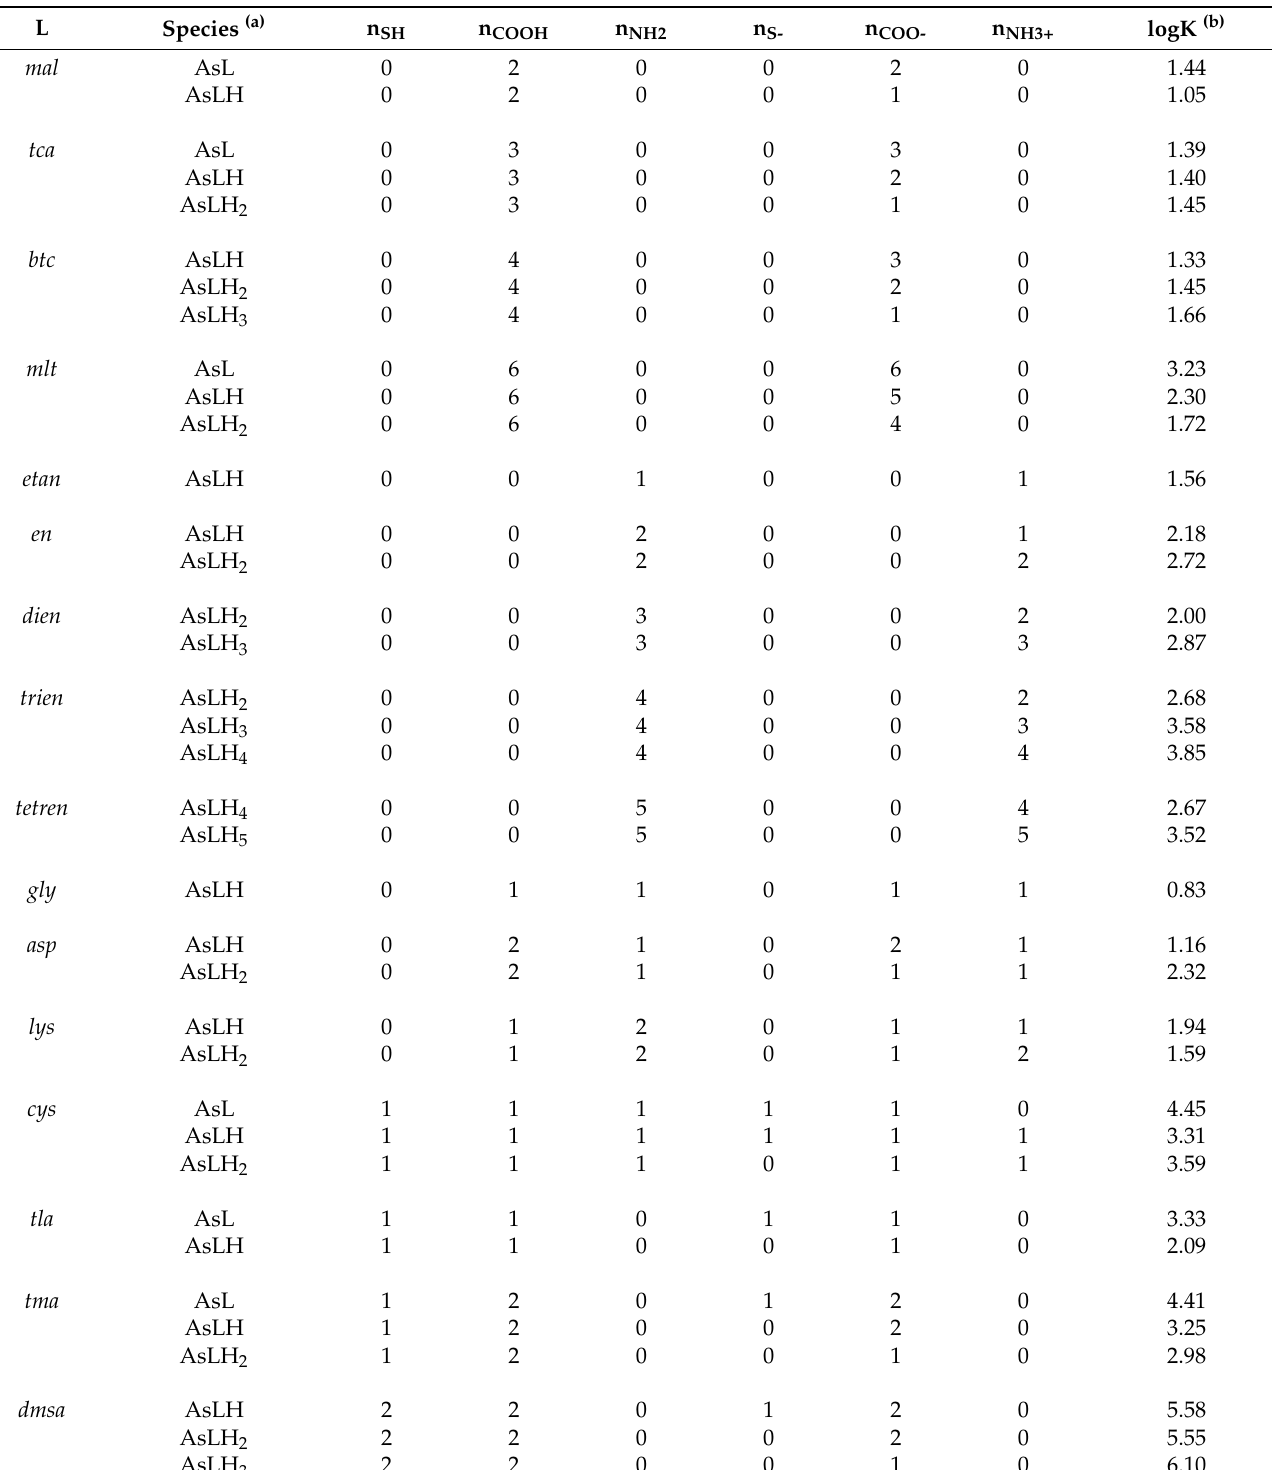
Table 2. Stepwise formation constants of As(III)–ligand species in NaCl at I = 0.15 mol/L and T = 298.15